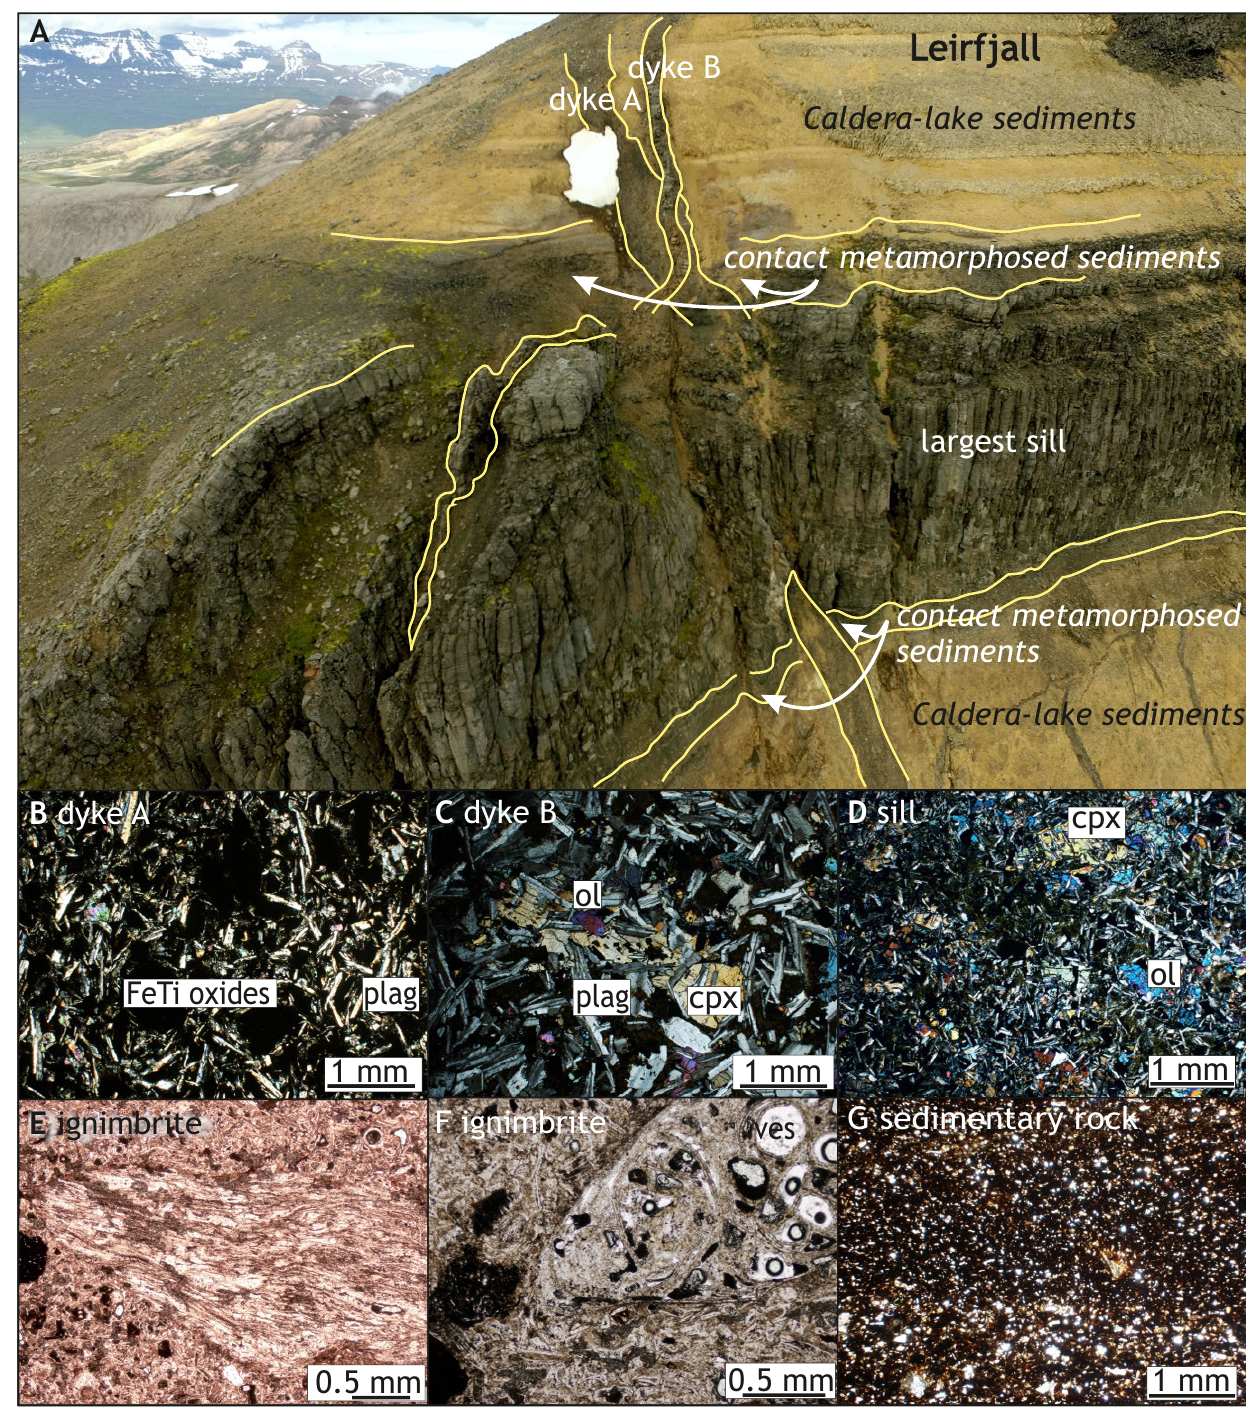
Figure 4: UAV photo of intrusions in Leirfjall and photomicrographs of thin sections of intrusions and host-rocks in the study area. [A] Photograph, taken by the UAV, of the southwestern part of the summit of Leirfjall showing basaltic intrusions in layered caldera-lake sediments. White patch below dyke A is snow. Scale varies with perspective. The main features are outlined in yellow. [B] Thin section image of dyke A. Plag = plagioclase. Cross-polarised light. [C] Thin section image of dyke B. Ol = olivine, cpx = clinopyroxene. Cross-polarised light. [D] Thin section image of a sample from the thickest sill in Leirfjall. Cross-polarised light. [E] Thin section image of Hvítserkur ignimbrite displaying a pumice fragment in a matrix of glass shards. Plane-polarised light. [F] Thin section image of Hvítserkur ignimbrite displaying a mafic enclave (left middle) in a matrix of glass shards. Ves = vesicle. Plane-polarised light. [G] Thin section image of hornfels mud-siltstone sampled above the thickest sill in Leirfjall. Plane-polarised